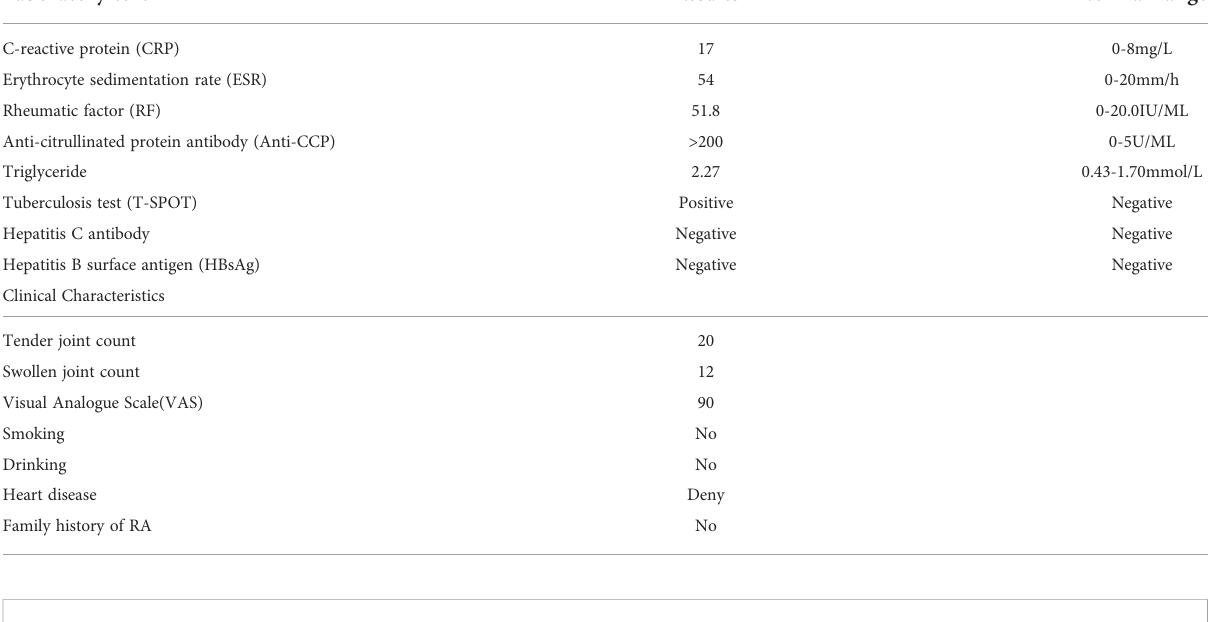
TABLE 2 Clinical information of the patient on November, 2020.